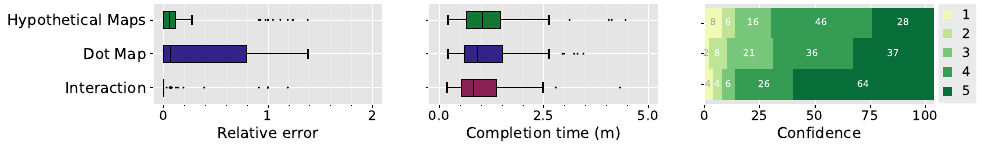
Figure 5. Results of the find extremes task.